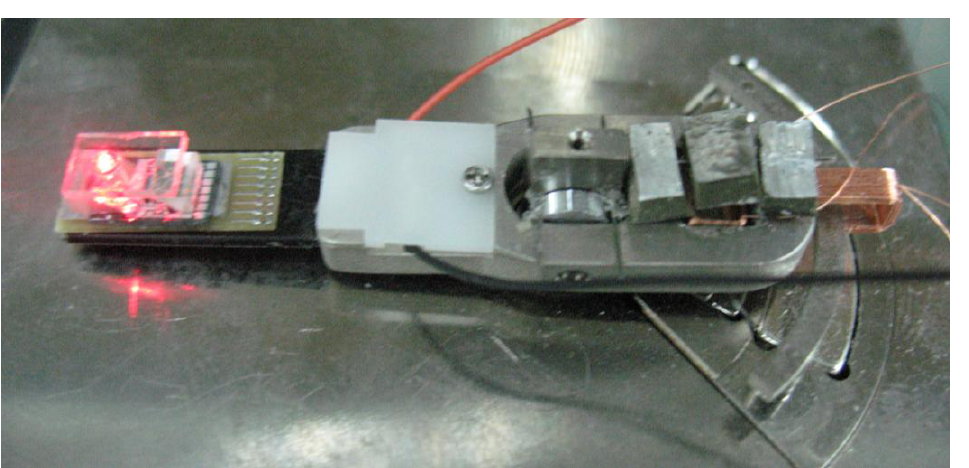
Figure 13. Normalized amplitudes of vibrations when μ = 0.1~1 and ζ